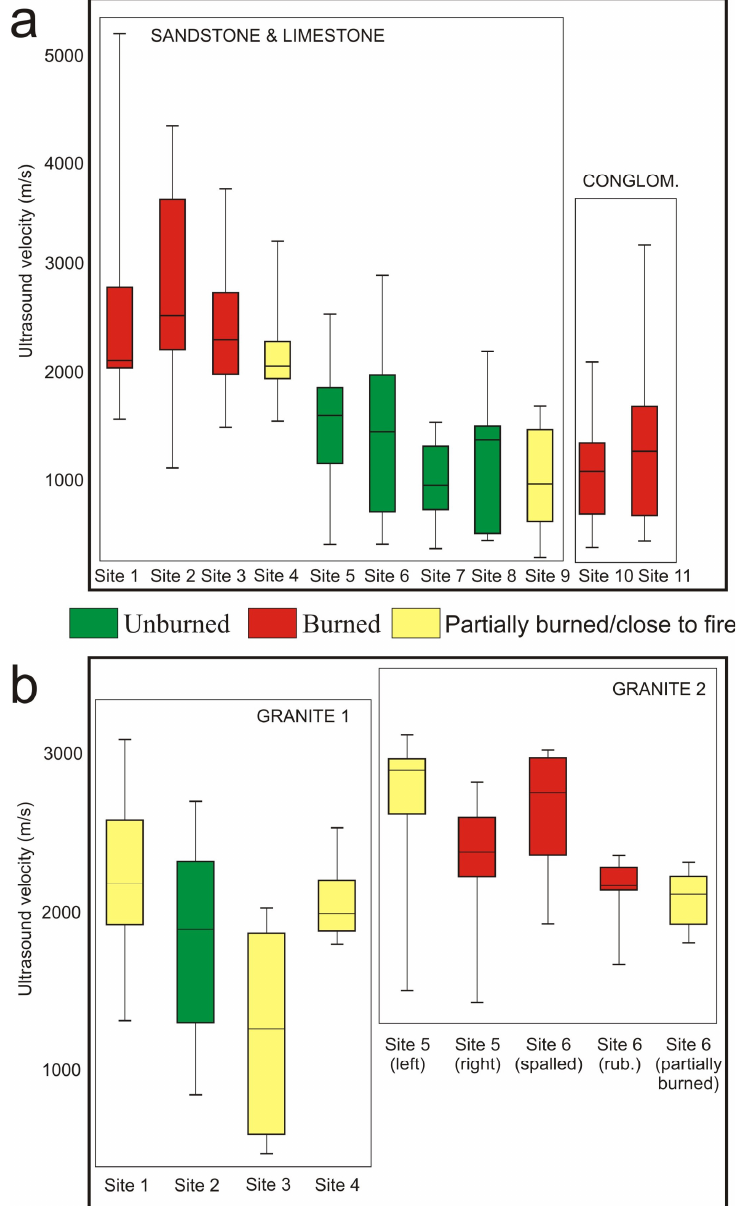
Figure 10. Ultrasound pulse velocity of the two studied areas: ( a ) Oliana across the entire climbing wall; ( b ) Cadalso de los Vidrios with two different granites along the various